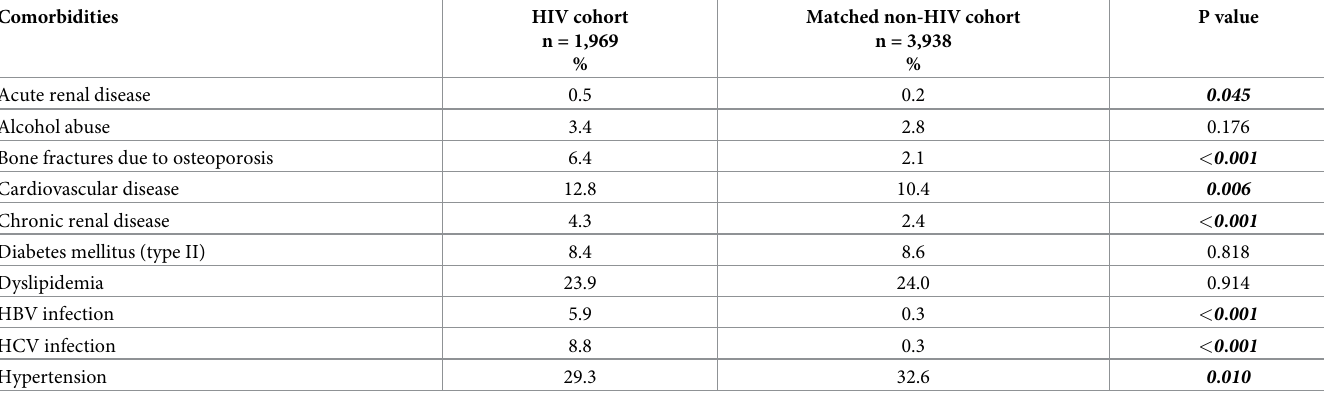
Table 2. Prevalence of specific comorbidities in PLHIV and a matched non-HIV cohort over the previous 12 months.